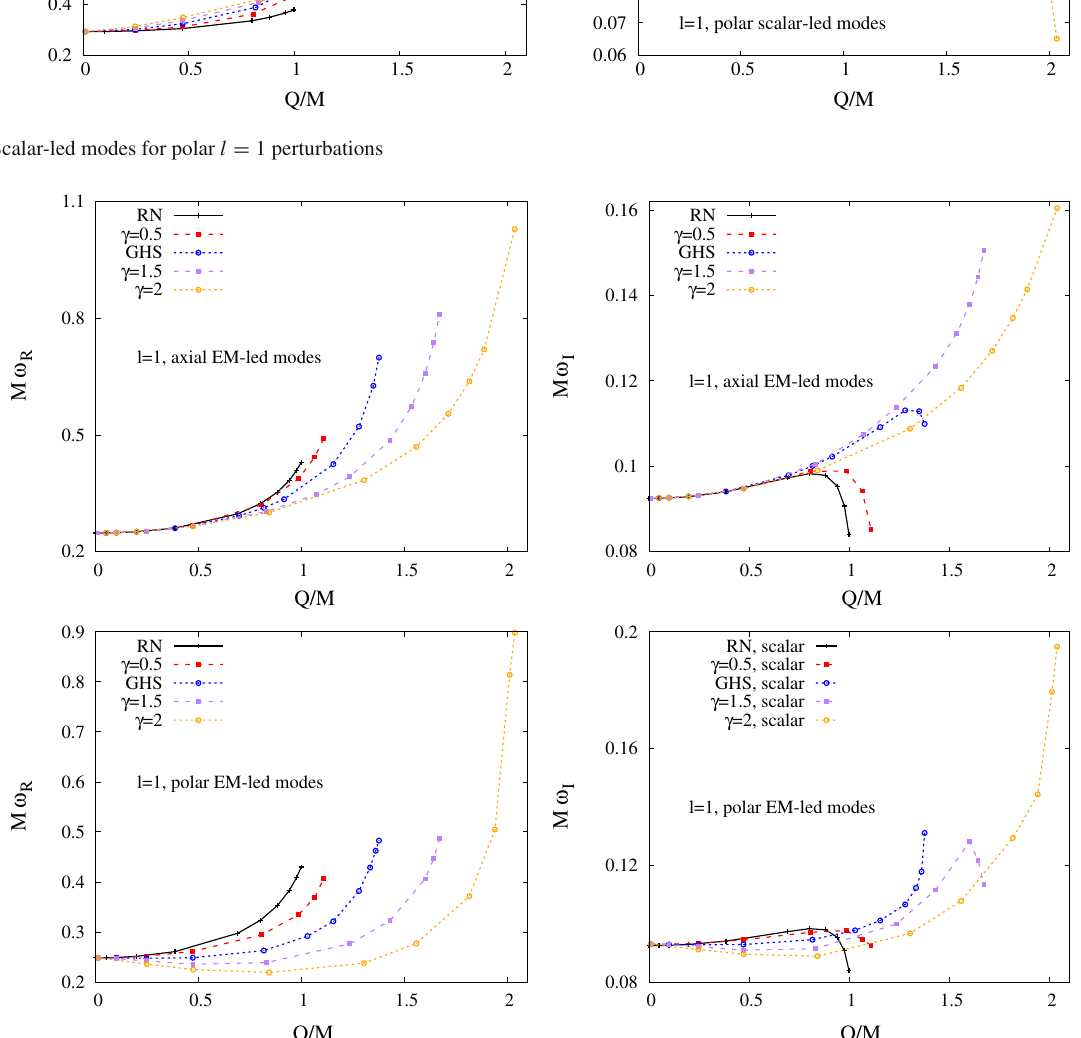
Fig. 4 EM-led modes for l = 1 perturbations: axial (upper) and polar (lower)